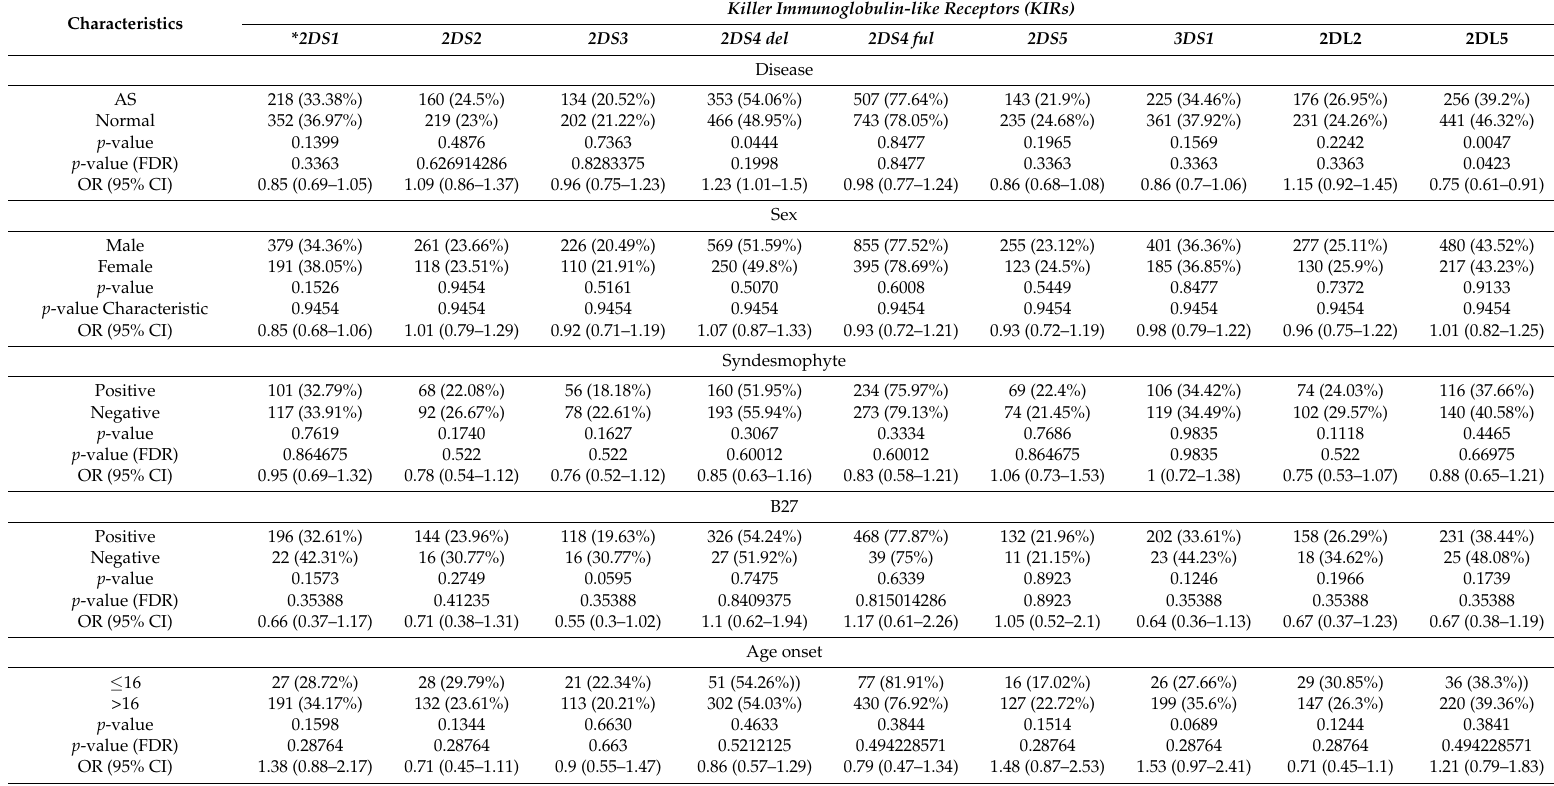
Table 4. Association of the KIRs with Taiwanese AS susceptibility and clinical